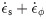
Maintenance of cell polarization at the mating projection tip via mechanical feedback.A, A cell initially polarized at the tip, as indicated by the distribution of Cdc42, loses polarization in the absence of mechanical feedback. The cell shape does not change over the short timescale of depolarization. B, An initially depolarized cell (uniform and low Cdc42 concentration) polarizes and grows steadily in the presence of mechanical feedback. C, Polarized or depolarized cell states for varying values of the mechanical feedback strength. Small feedback strengths lead to depolarized solutions (loss of Cdc42 localization at the tip). For feedback strengths above a threshold, cell polarization is stably maintained at the tip during cell growth (Polarized stable solution). The black outlined point denotes the stable solution seen in B and D-G. D-G, Steady state spatial profiles for cell wall expansion rate ϵ˙s+ϵ˙ϕ (D), active Bni1 density (E), Cdc42 density (F) and cell wall thickness h (G).